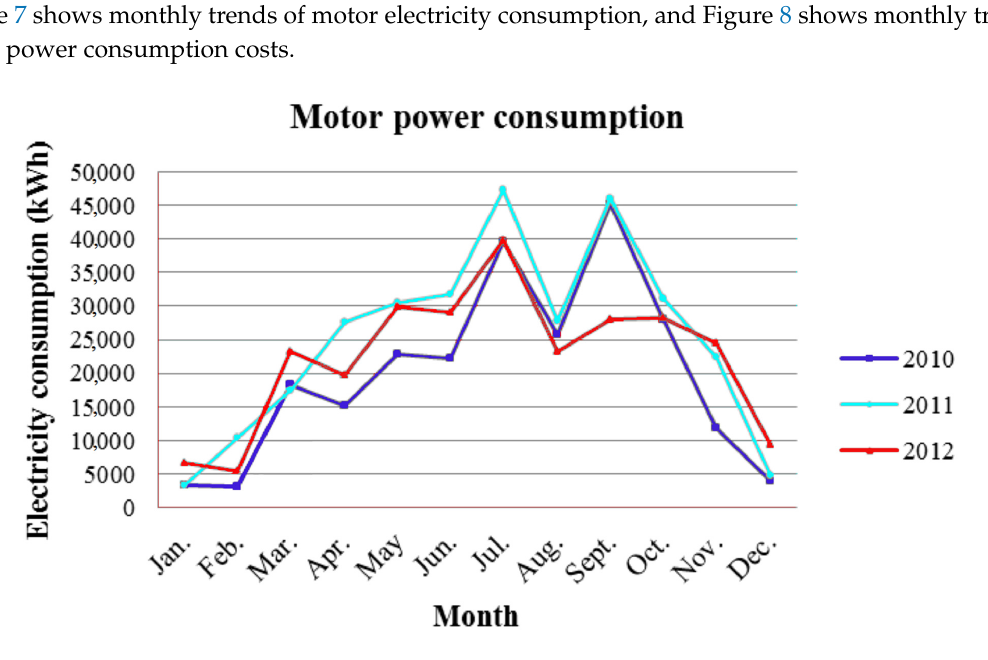
Figure 7. Power consumption of the motor—monthly data.